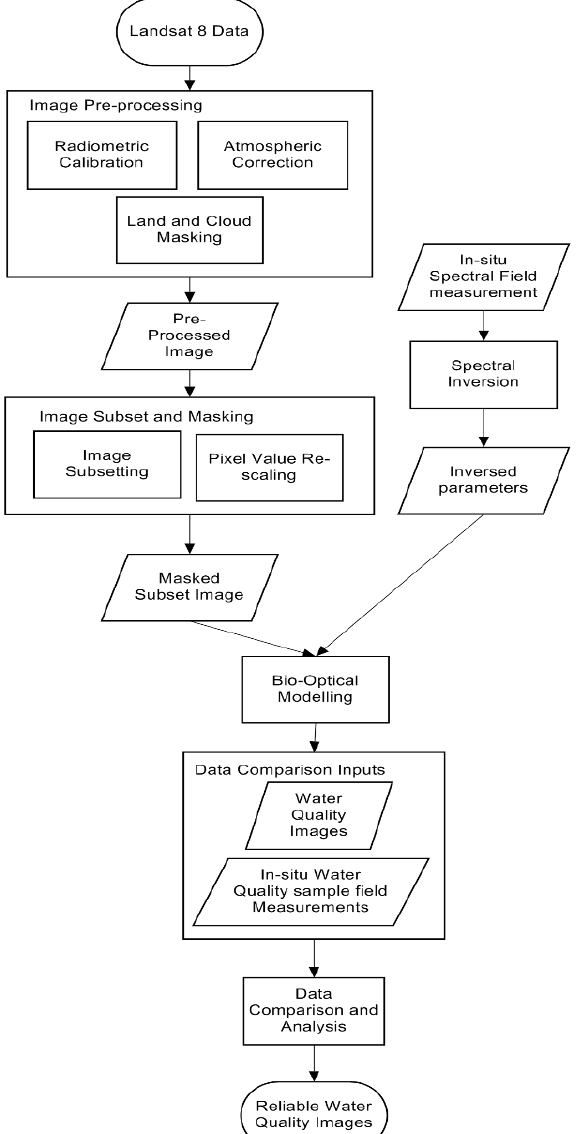
Figure 2. Methodology for water quality mapping using